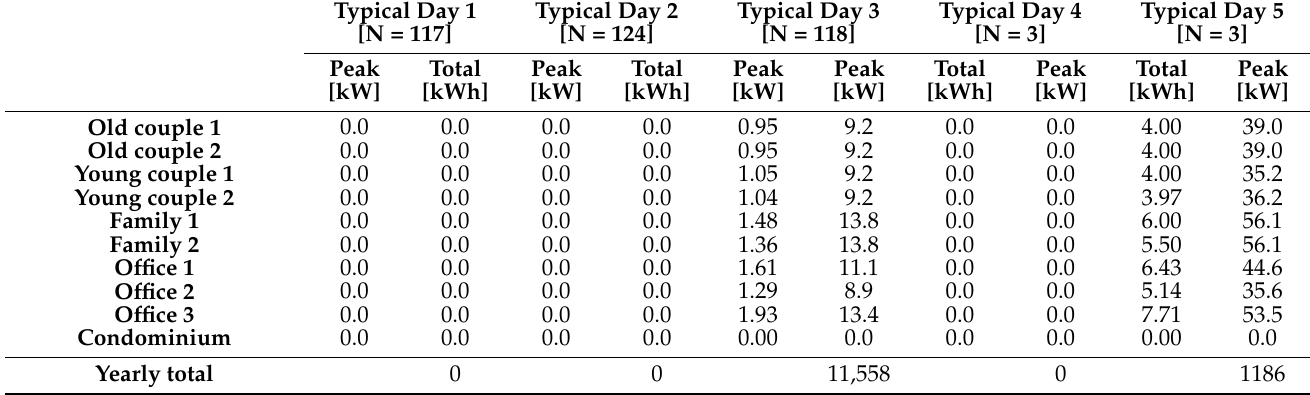
Table 5. Cooling demand for each apartment in each typical day, in terms of peak power demand and total cooling demand during the day. The yearly total demand is calculated by multiplying the total cooling demand of each typical day for its cardinality (N, according to the nomenclature used in Equation